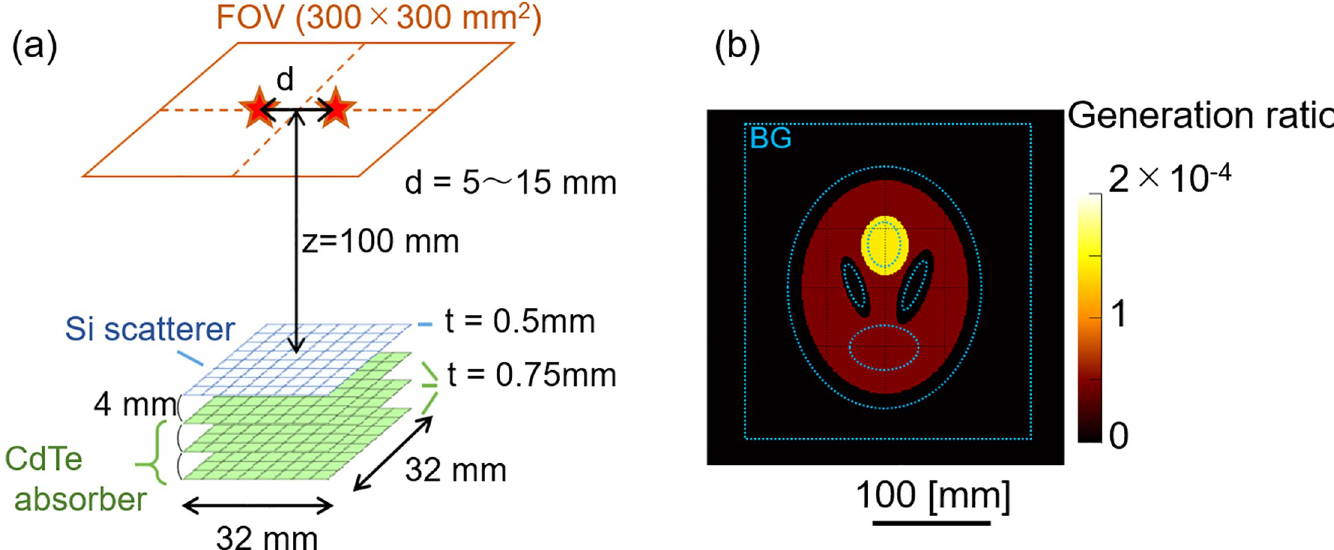
Fig 1. Imaging setup (a) and source distribution of ellipsoid phantom (b). The blue dotted line in (b) represents the region of interest for the semi-quantitative and uniformity tests.